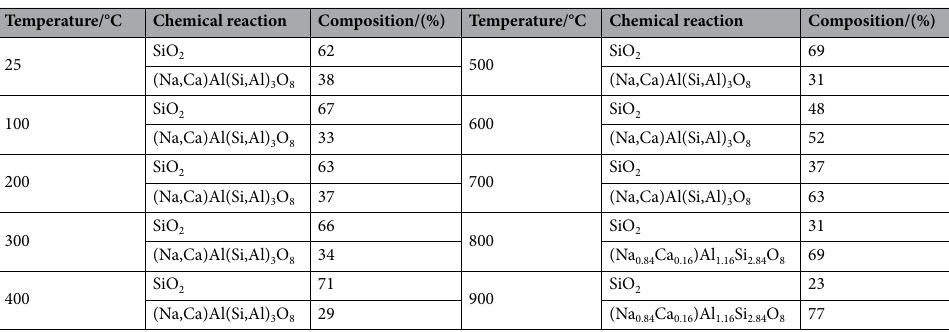
Table 2. Main mineral composition of coarse sandstone after high temperature